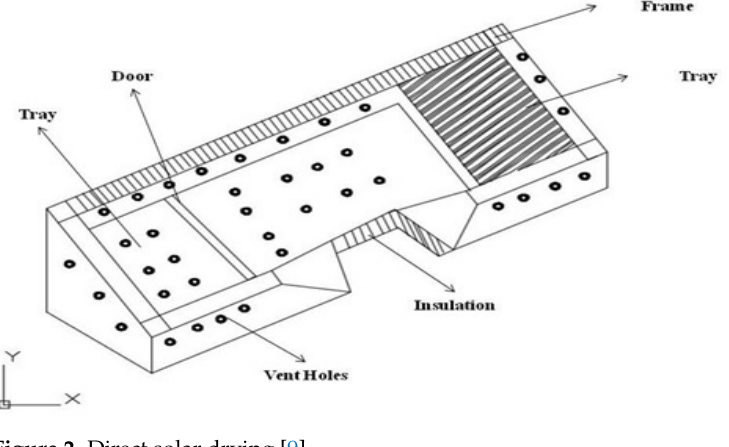
Figure 2. Direct solar drying [9].